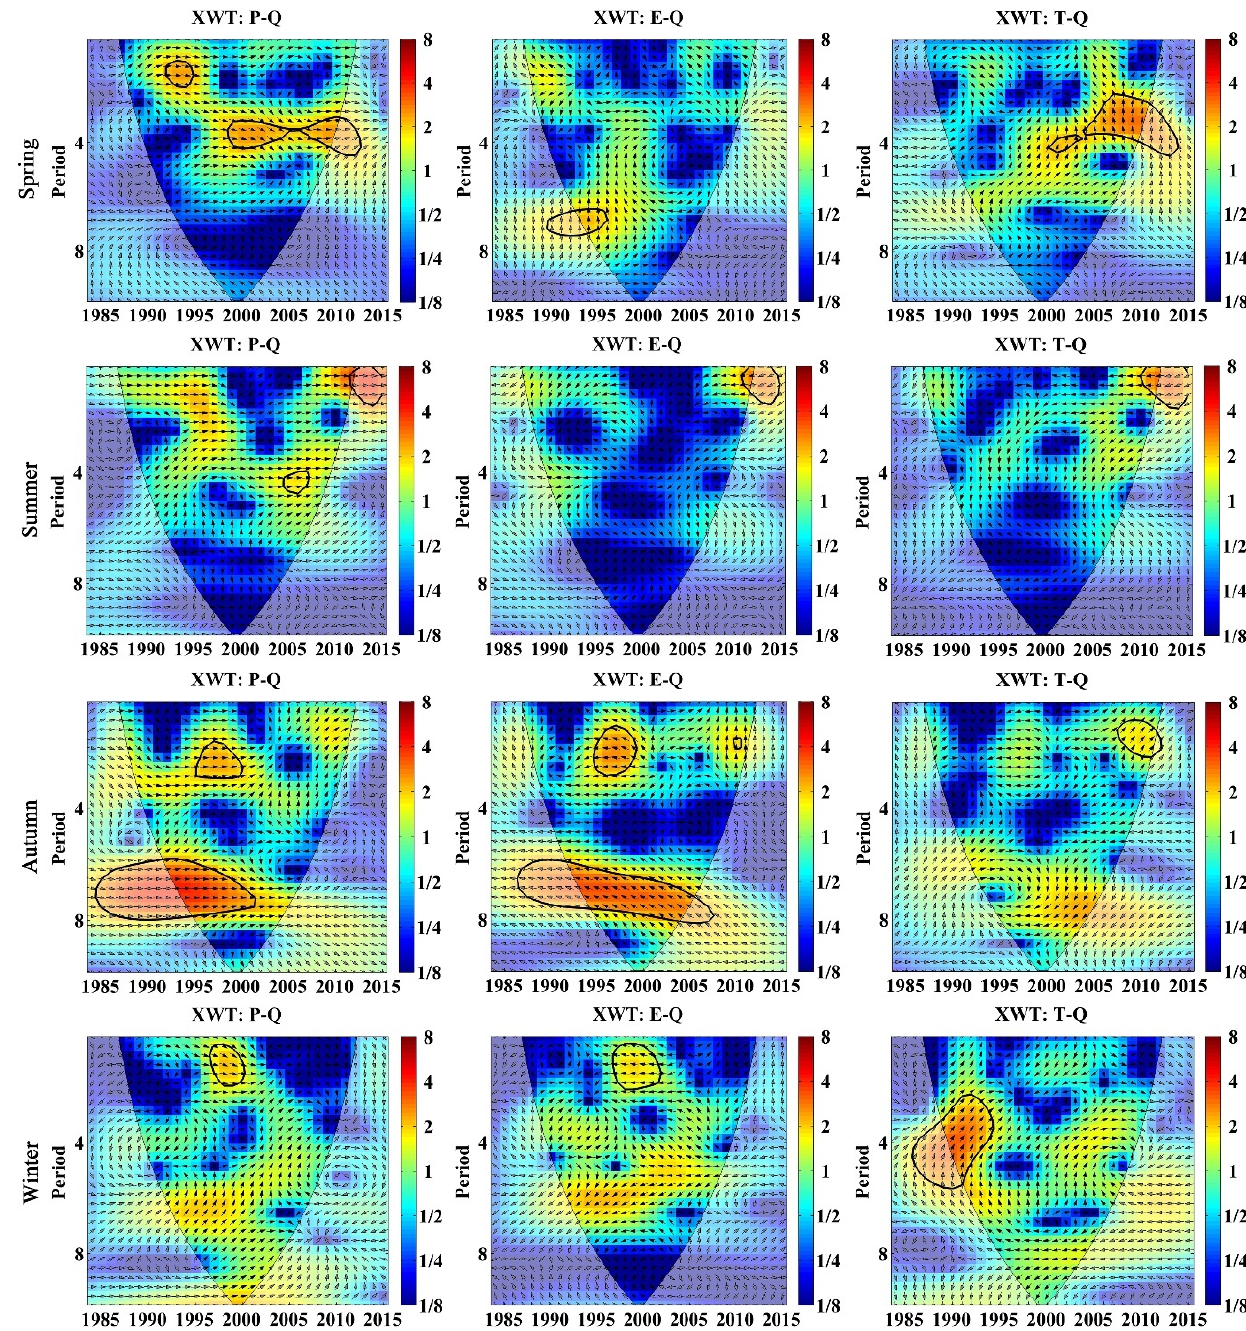
Figure 14. XWT between runoff and rainfall, evaporation and temperature on monthly scale. The thick black contour designates the 5% significance level against red noise and the cone of influence (COI) where edge effects might distort the picture is shown as a lighter shade. Arrows denote relative phase difference: The arrows from left to right indicate that the influencing factors and runoff are in the same phase, which implies a positive correlation; the arrows from right to left indicate an inverse phase, which implies a negative correlation; the downward arrows indicate that the influence factor is 90° ahead of the runoff change and the upward arrows indicate that the influence factor is 90° lagging the runoff.